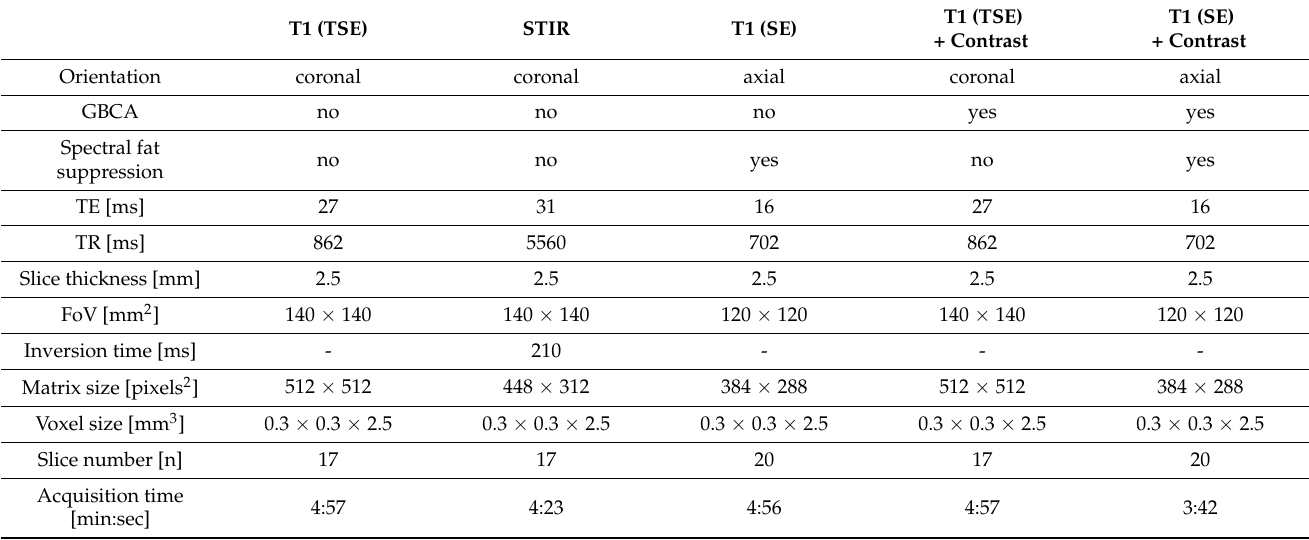
Table 2. Acquisition parameters of MRI